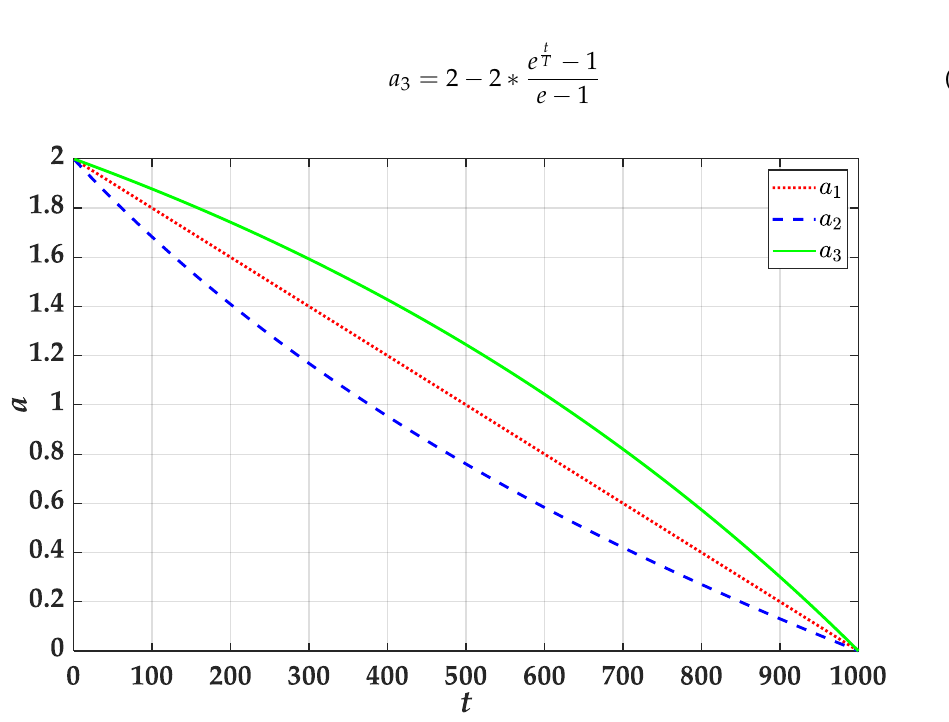
Figure 2. The change of convergence factor.